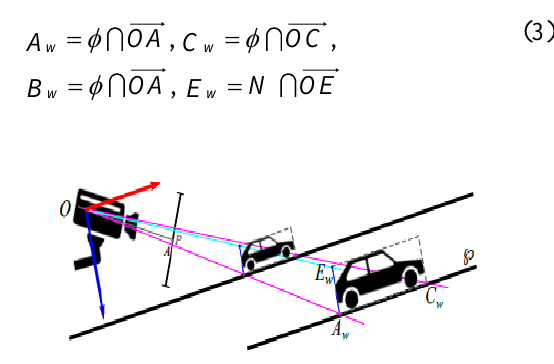
Figure 3. Representation of the camera, image plane, and two arbitrary motion